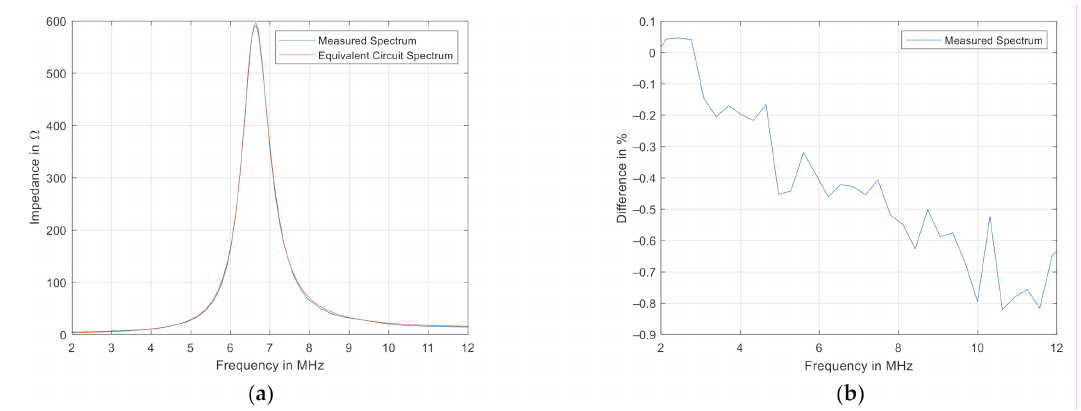
Figure 13. ( a ) Comparison of the measured spectrum and the modelled system. ( b ) Percentage difference between the measured spectrum and the modelled